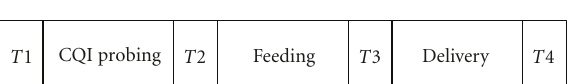
Figure 4: Detailed time-span of the BROAD scheme.